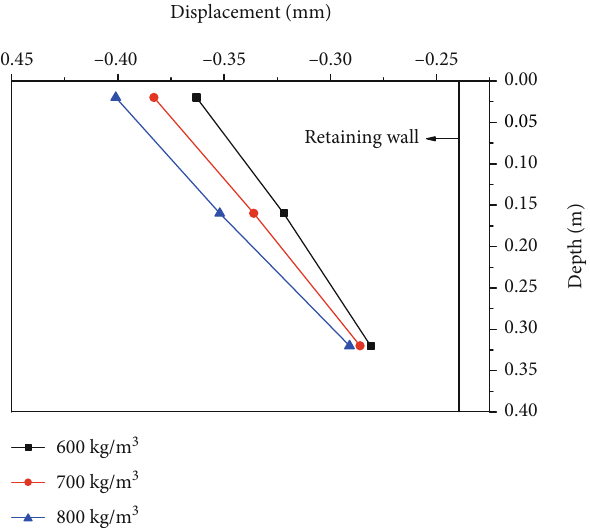
Figure 11: Displacement changes of retaining wall under di ff erent densities of lightweight foamed